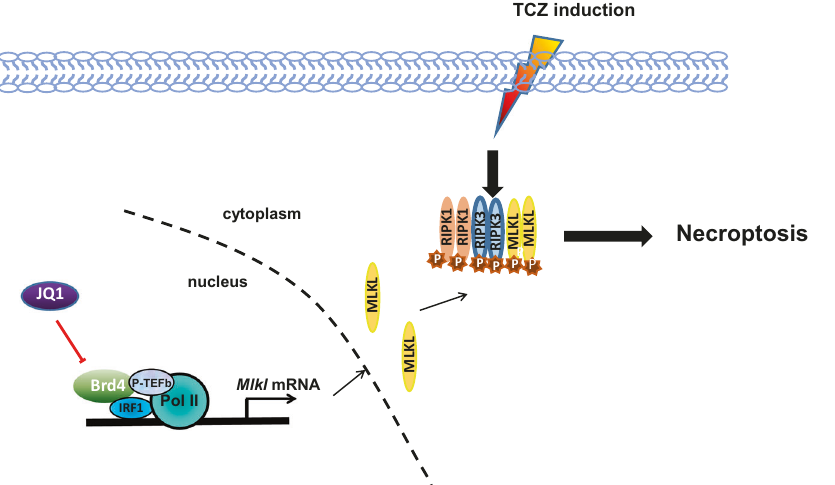
Fig. 3 The necroptosis mechanism regulated by Brd4. Under the signal of necroptosis, Brd4 is recruited to the promoter of MLKL and forms a transcription complex with IRF1, P-TEFb, and RNA polymerase II to regulate the expression of MLKL, which leads to necroptosis. BET inhibitors such as JQ1 interferes with the transcription complex